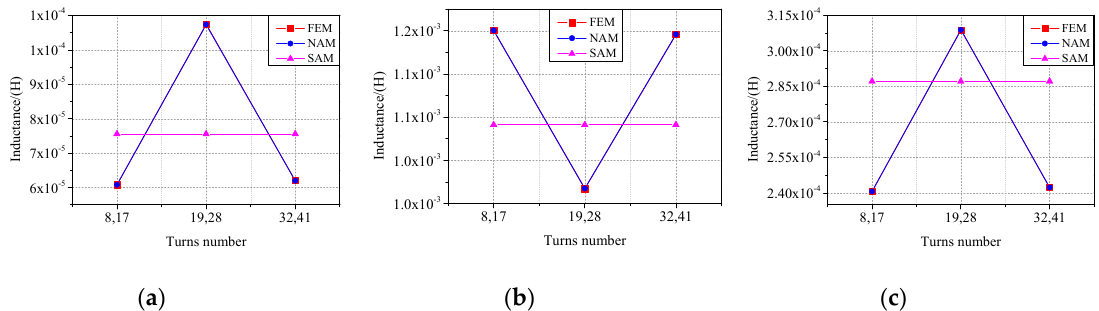
( a ) self-inductance in faulty part; ( b ) self-inductance in healthy part; ( c ) mutual inductance.